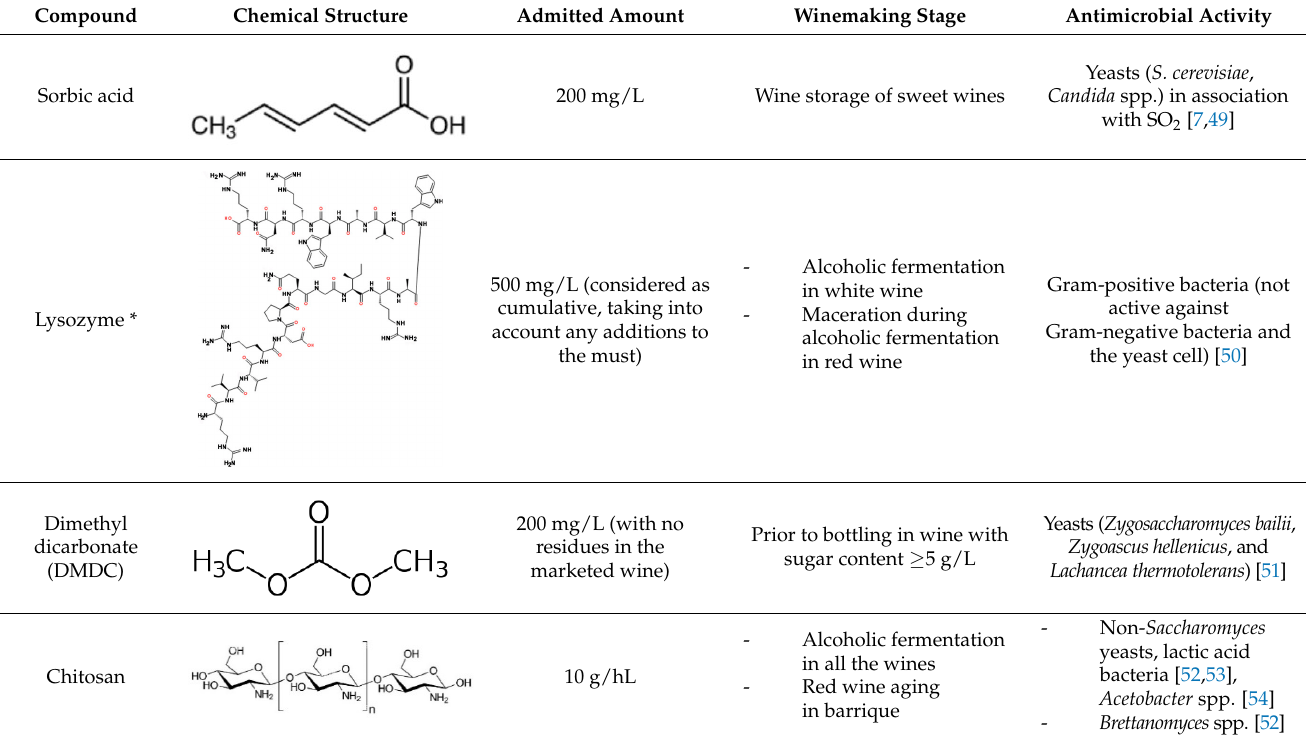
Table 2. Main applications, authorized doses, and antimicrobial activities of chemical compound alternatives to SO 2 . Compound Chemical